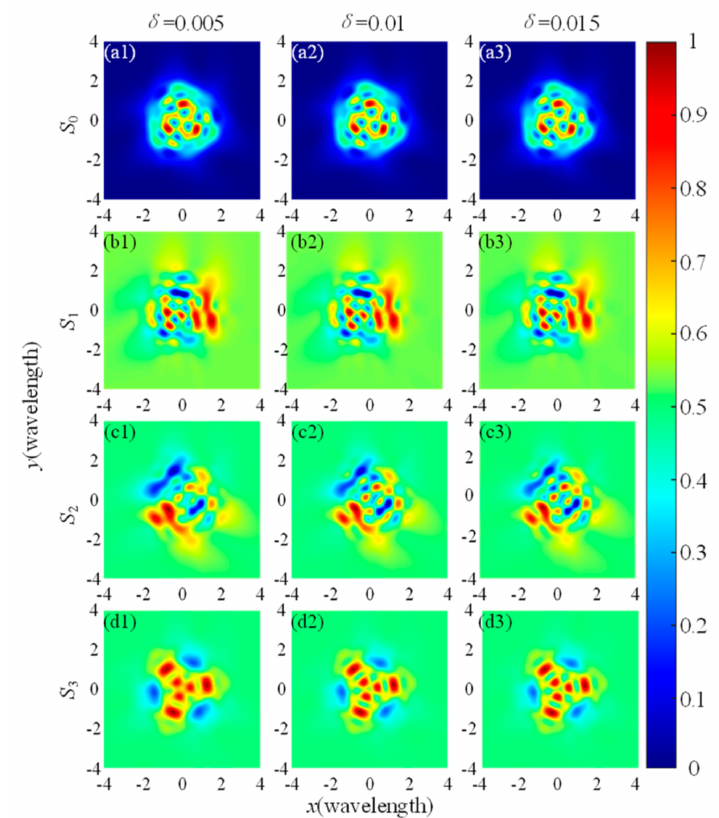
Figure 7. The Stokes parameters of different the spatial coherence lengths δ in the transverse plane. ( l = 3, p ’ = 1, and n = 4). The Stokes parameters of ( a1 – d1 ) the spatial correlation lengths δ = 0.005 m, ( a2 – d2 ) the spatial correlation lengths δ = 0.01 m, and ( a3 – d3 ) the spatial correlation lengths δ = 0.015